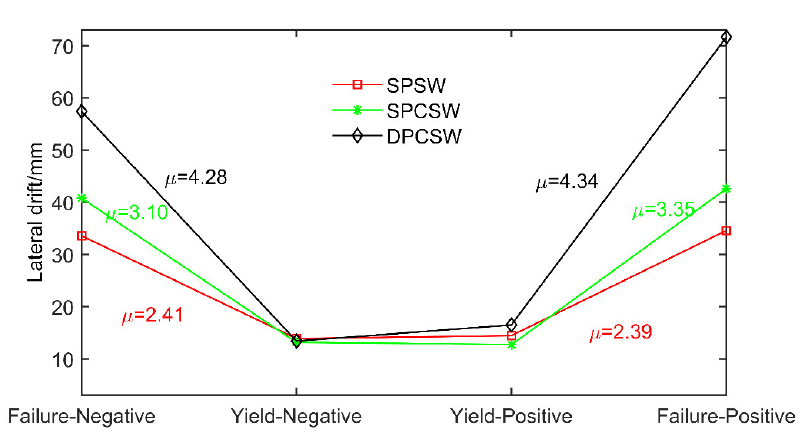
Figure 15. Ductility of all three